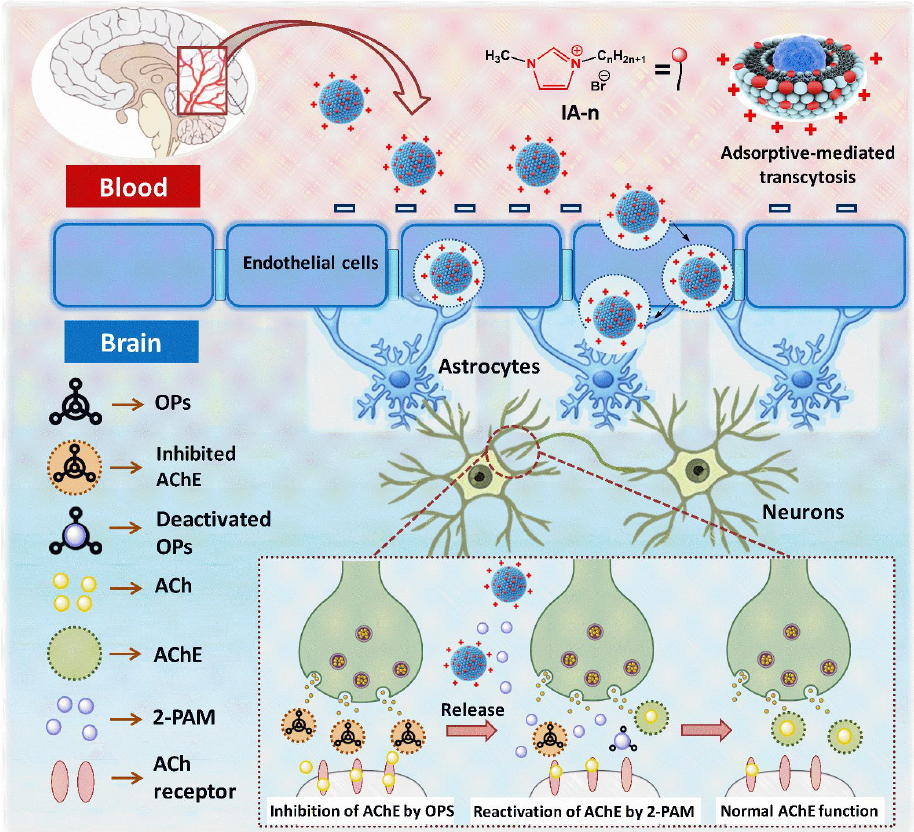
Scheme 1. Mechanism of IA-16/PC liposome penetration of the blood–brain barrier and reactivation of the inhibited AChE. To evaluate the ability of 2-PAM-loaded cationic IA-16/PC liposomes to target and cross the BBB, pharmacokinetic studies were performed in brain tissues and plasma. Comparison of the pharmacokinetic dependences of free [17] and liposomal 2-PAM (in IA-16/PC liposomes, the ratio is 0.029/1) (Figure 9b) in rat brains suggests that encapsu- lated oxime penetrates through the BBB much more efficiently compared to the free form. Higher 2-PAM concentration in the case of the liposomal form is observed over the whole period that was monitored by HPLC. It should be noted that previously, after free 2-PAM (25 mg/kg) injection, the maximum concentration in the brain tissue was also